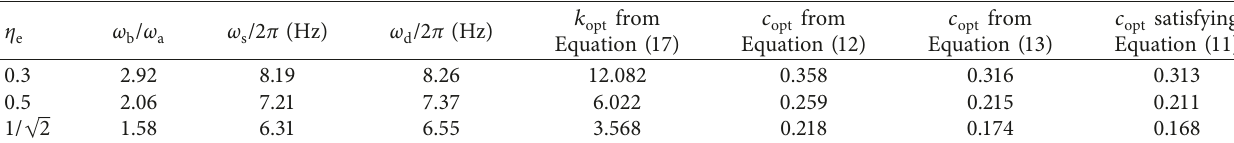
Table 2: Three test cases with their optimal P and D